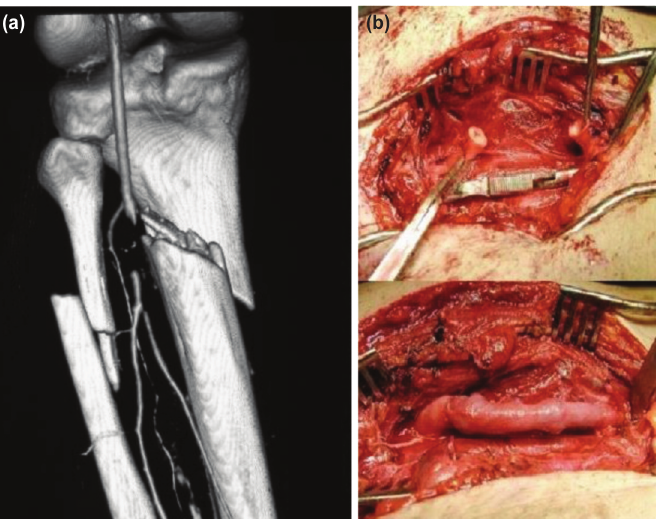
(a) CT Angiogram showing Injury to tibio-peroneal trunk in Grade 3C open fracture (b) managed by thrombectomy followed by Fig. 4: reverse saphenous vein graft.